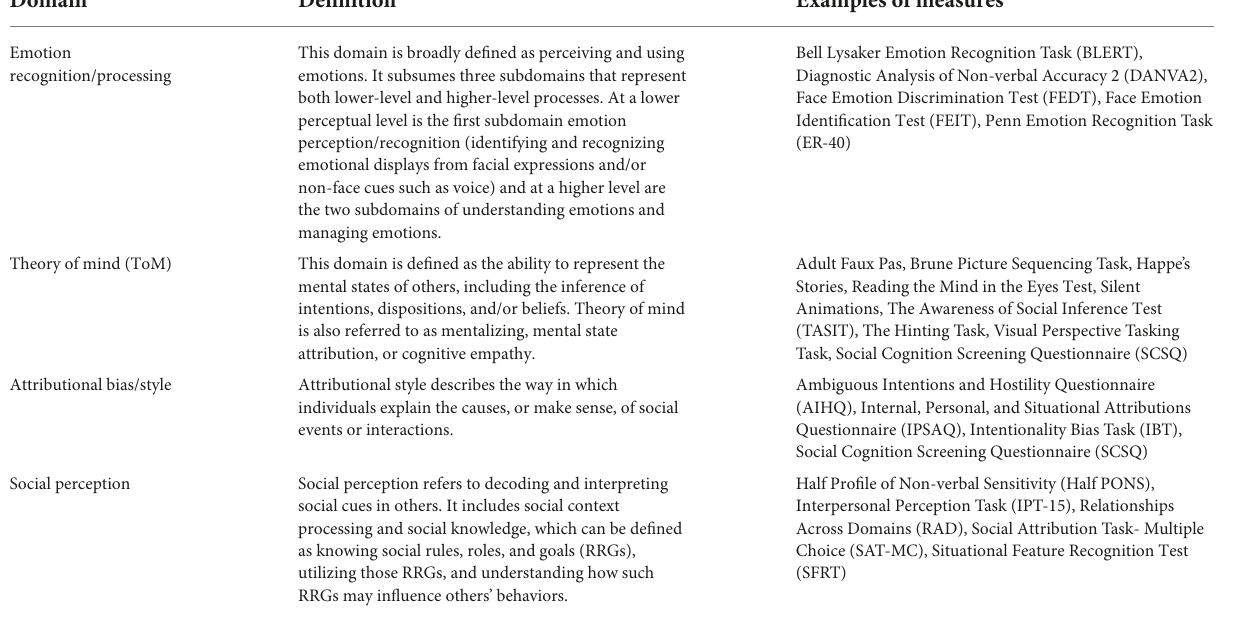
TABLE 1 Key domains of social cognition [adapted from Pinkham et al. (2014)]. Domain Definition Examples of measures Emotion